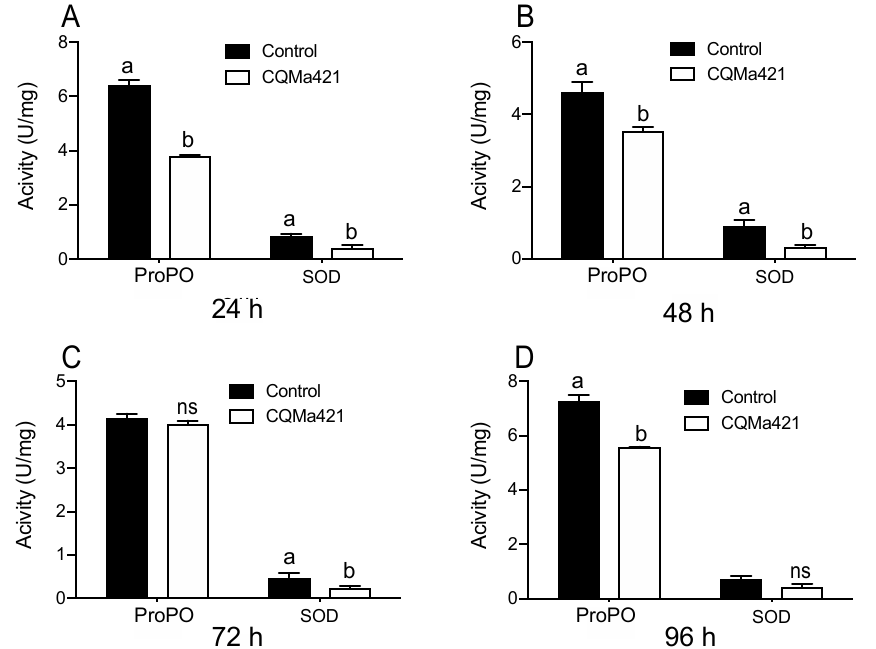
Figure 3. ProPO and SOD activities of L. migratoria after challenge with M. anisopliae CQMa421. ( A ) Enzymatic activity of L. migratoria after treatment with M. anisopliae CQMa421 for 24 h; ( B ) Enzymatic activity of L. migratoria after treatment with M. anisopliae CQMa421 for 48 h; ( C ) Enzymatic activity of L. migratoria after treatment with M. anisopliae CQMa421 for 72 h; ( D ) Enzymatic activity of L. migratoria after treatment with M. anisopliae CQMa421 for 96 h. The di ff erent letters indicate significant di ff erences, and the bars represent the means ±